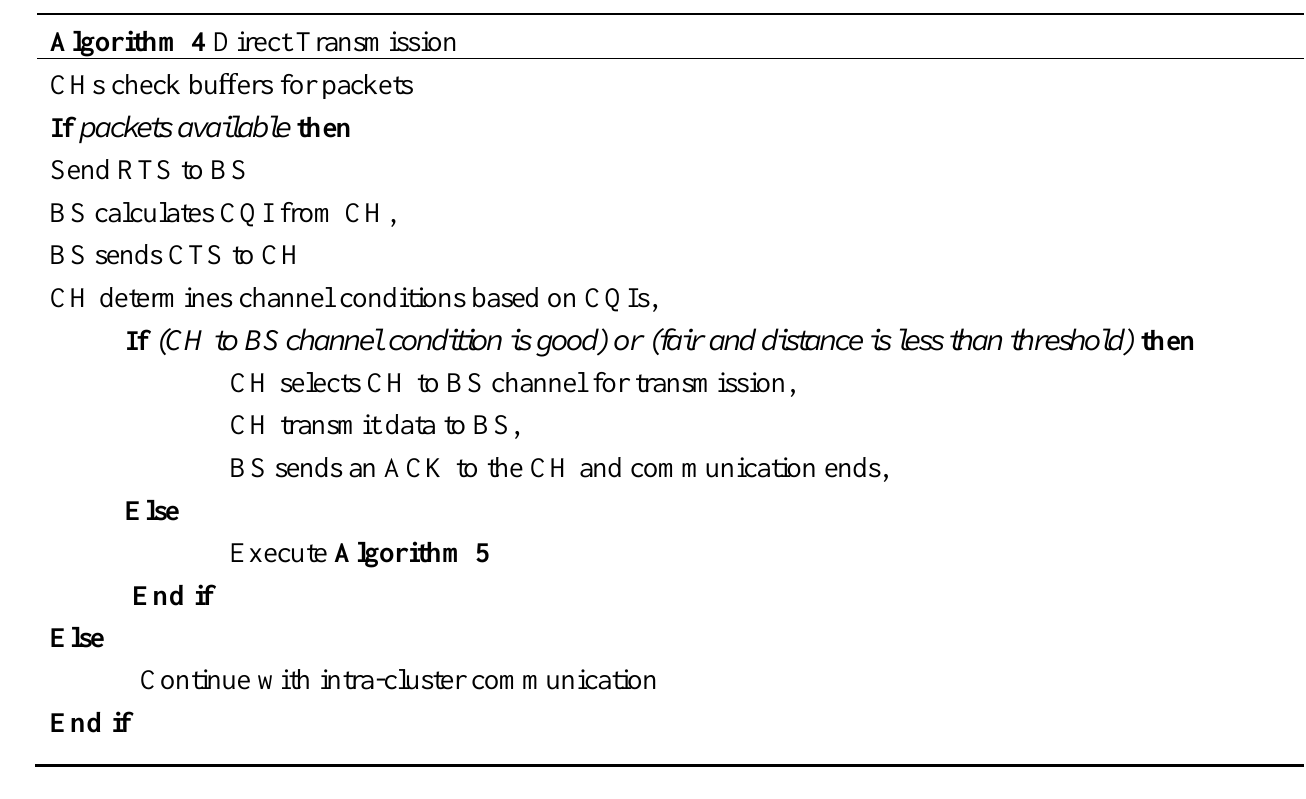
Figure 6. Cluster head direct transmission